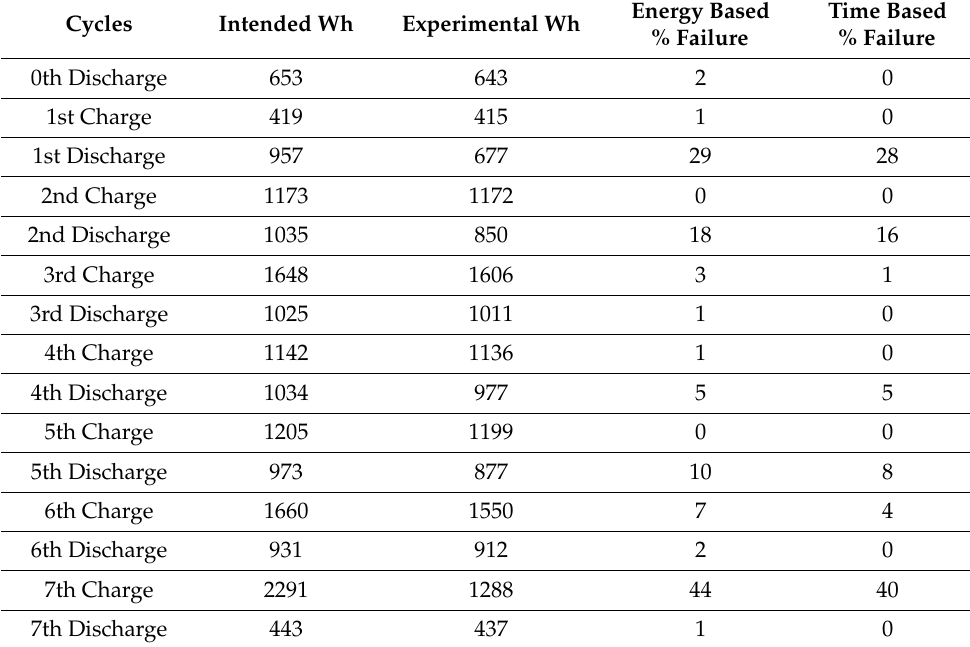
Table 3. VRFB energy during charge/discharge cycle 30 L for S P = 1 / 2 , S T = 1 / 2